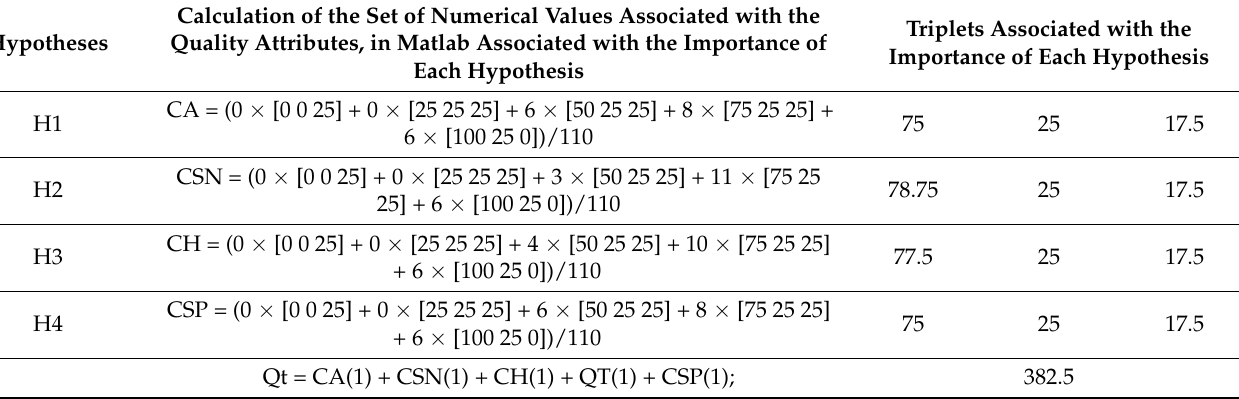
Table 3. Calculation of the triplets associated with the weight of the importance of each hypothesis.